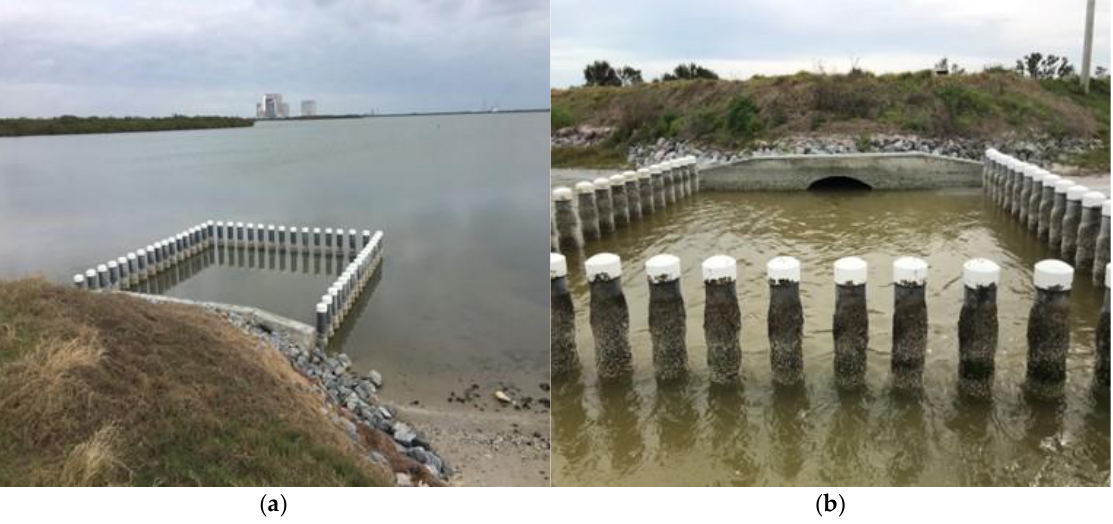
Figure 2. Integrate-Transfer-Launch Impoundment culverts ( a ) Manatee exclusion bollards installed around the ITL impoundment culverts.; ( b ) ITL culvert surrounded by bollards which have been fouled by barnacles near the water line.